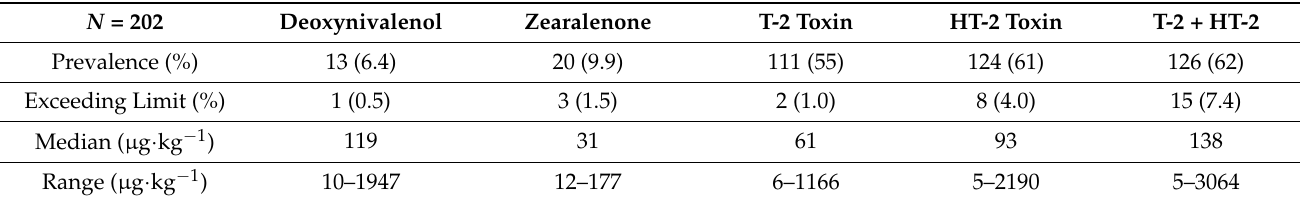
Table 5. Basic descriptive statistics for the detection of mycotoxins in oat samples, including samples over the